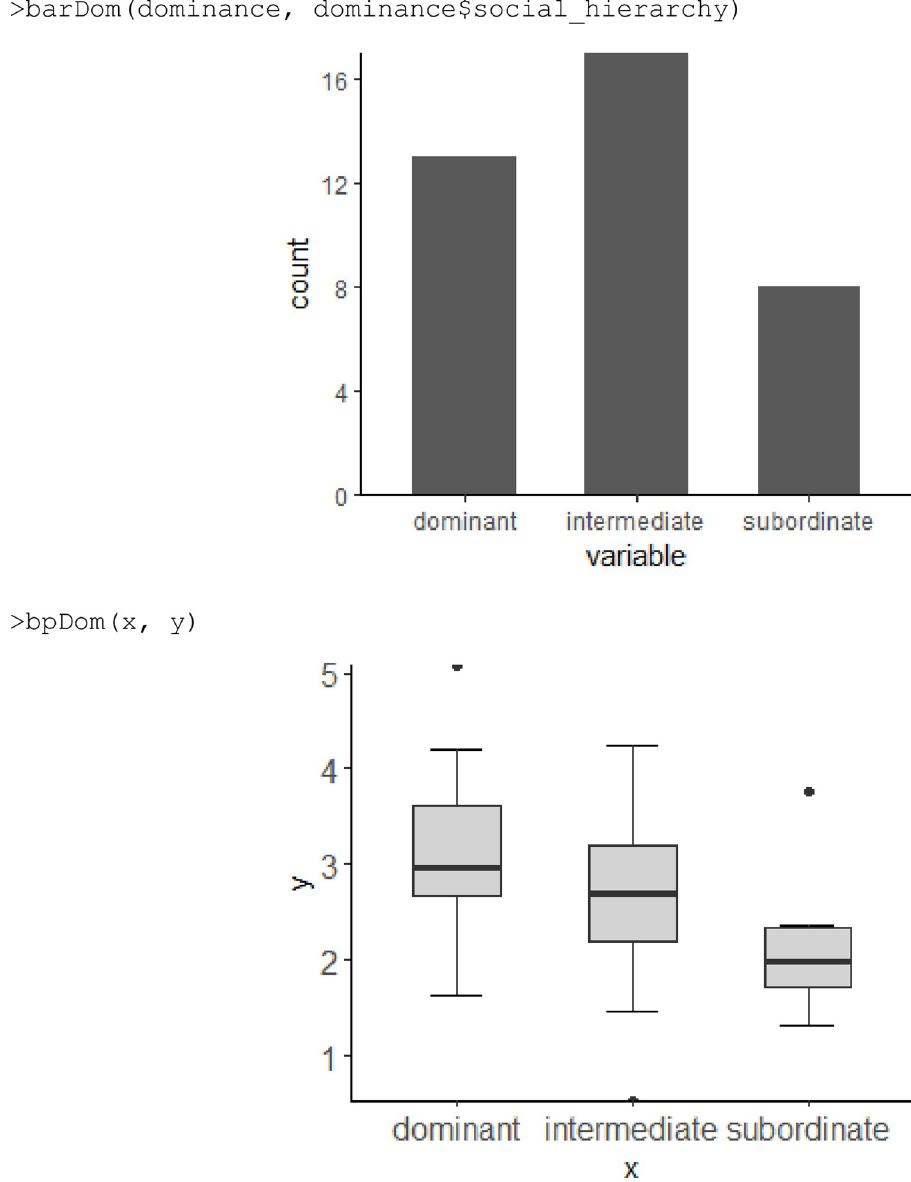
Fig 4. Example of barplot (above) and boxplot (below) using barDom and bpDom functions,